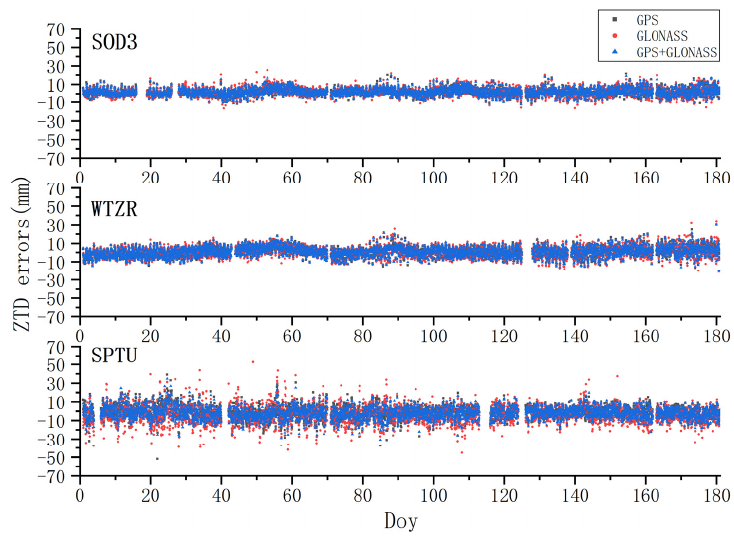
Figure 10. The ZTD error series of station SOD3, WTZR, and SPTU estimated with DD processing.